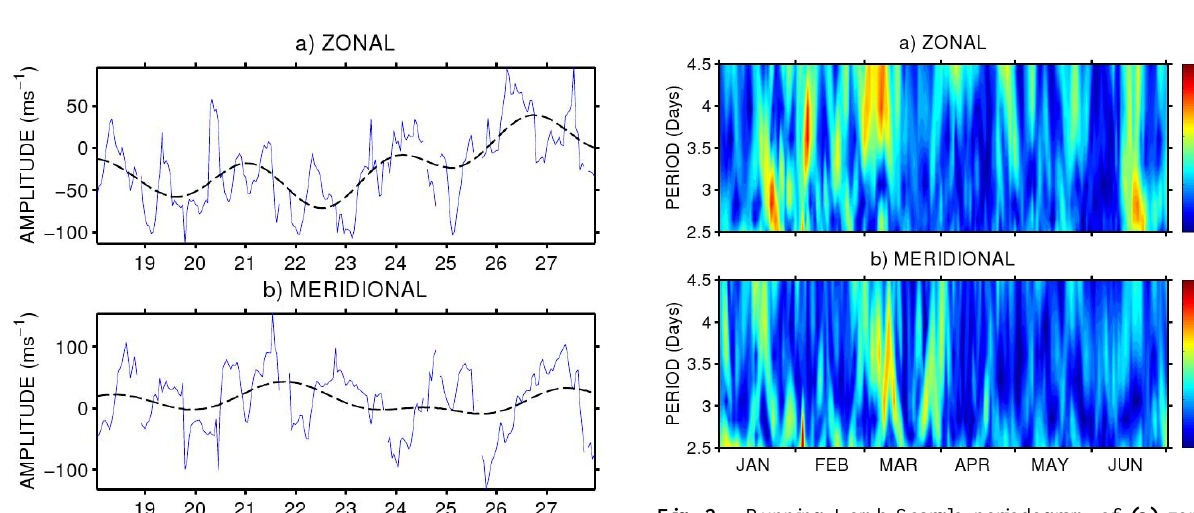
Fig. 2. Running Lomb-Scargle periodogram of (a) zonal and (b) meridional winds over Ascension Island for January–June 2005 at a height of